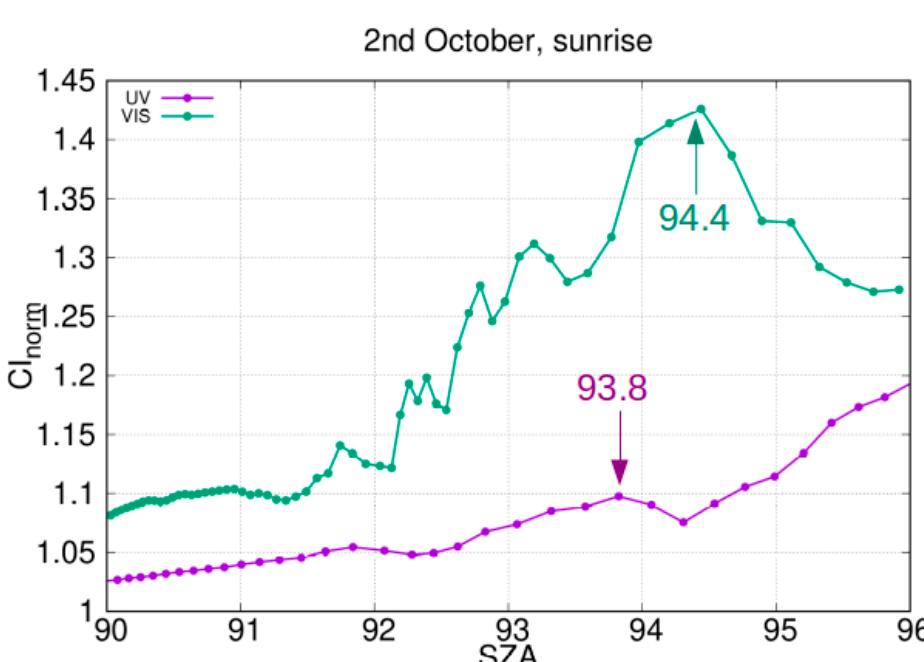
Figure 11. CI norm evolution obtained from recorded spectra on 2 October 2018 (sunrise) for UV (violet) and visible (green) measurements. SZA corresponding to the CI norm maximums are marked by arrows.